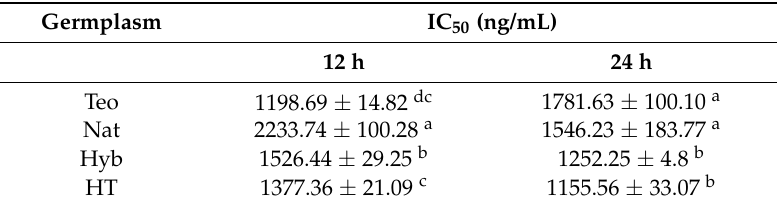
Table 3. Half maximal inhibitory concentration (IC 50 ) of zein peptides on the HepG2 cell line at various times of